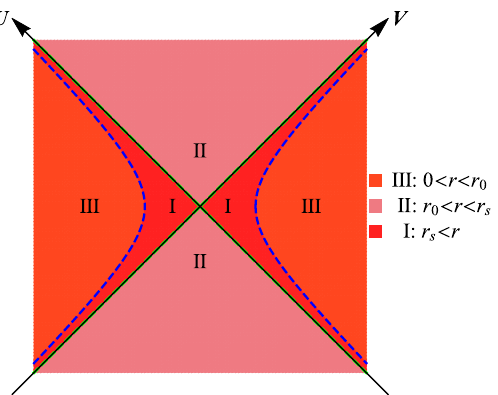
Fig. 2 The U – V plane of the Kruskal extension: The region I, II, III corresponds to region r > r s , r 0 < r < r s and 0 < r < r 0 respectively. The green solid line represents the acoustic horizon r = r s . The blue dotted line represents the location r = 0 and r = ∞ . The location r = r 0 is at infinity. We can see that the isochronal line t = 0 is a horizontallinethroughtheorigin.For t > 0,anisochronisastraightline sloping upward from the left region to the right region. When t → ∞ , the isochronal line is a line approaching the V axis. For t < 0, the situation is just the